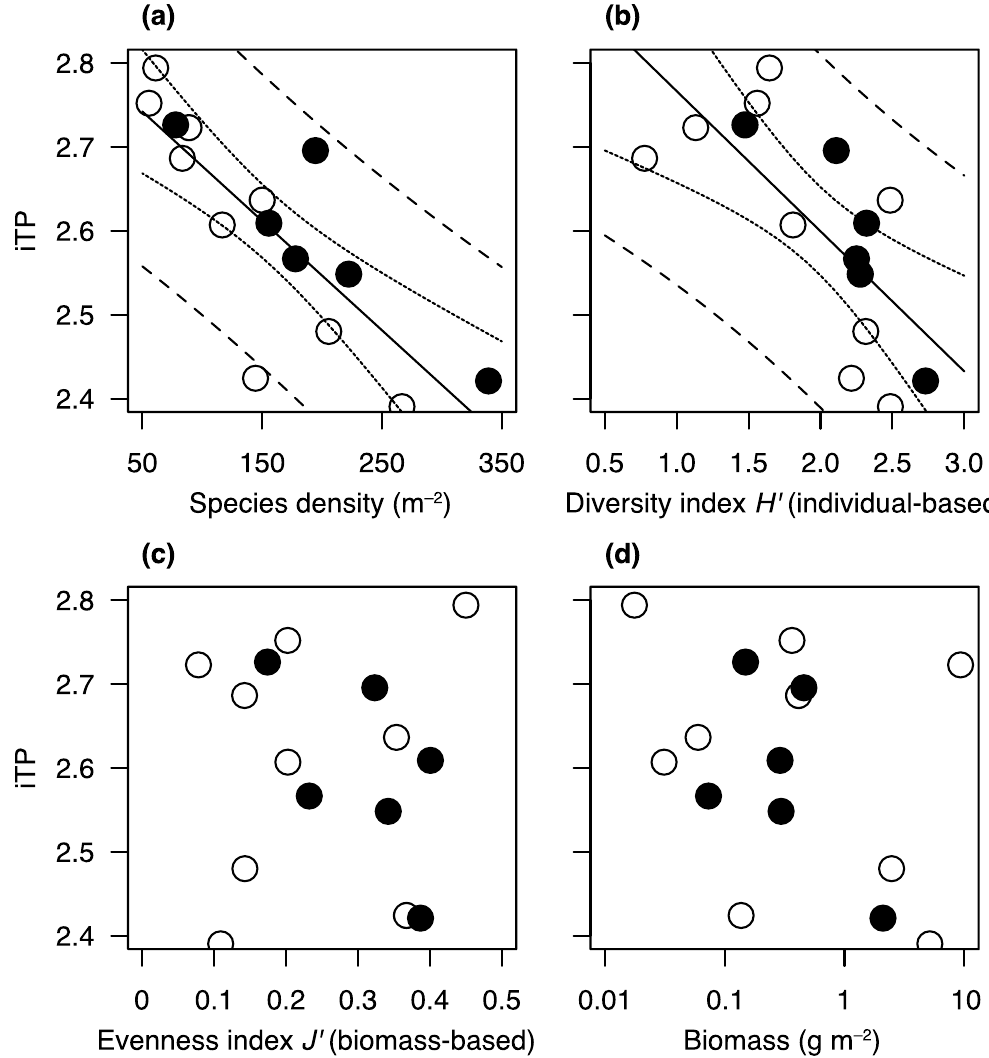
Figure 1. Relationships between integrated trophic position (iTP) for macroinvertebrates and ( a ) species density (m − 2 ), ( b ) the individual-based Shannon–Wiener diversity index ( H ′ ), ( c ) the biomass-based Pielou evenness index ( J ′ ), and ( d ) total biomass (g m − 2 ). Open circles indicate stream orders 1 or 2, and shaded circles indicate stream orders 3 or 4. Solid, dotted, and dashed lines in ( a ) and ( b ) represent the regression equation, 95% confidence interval, and 95% prediction interval,